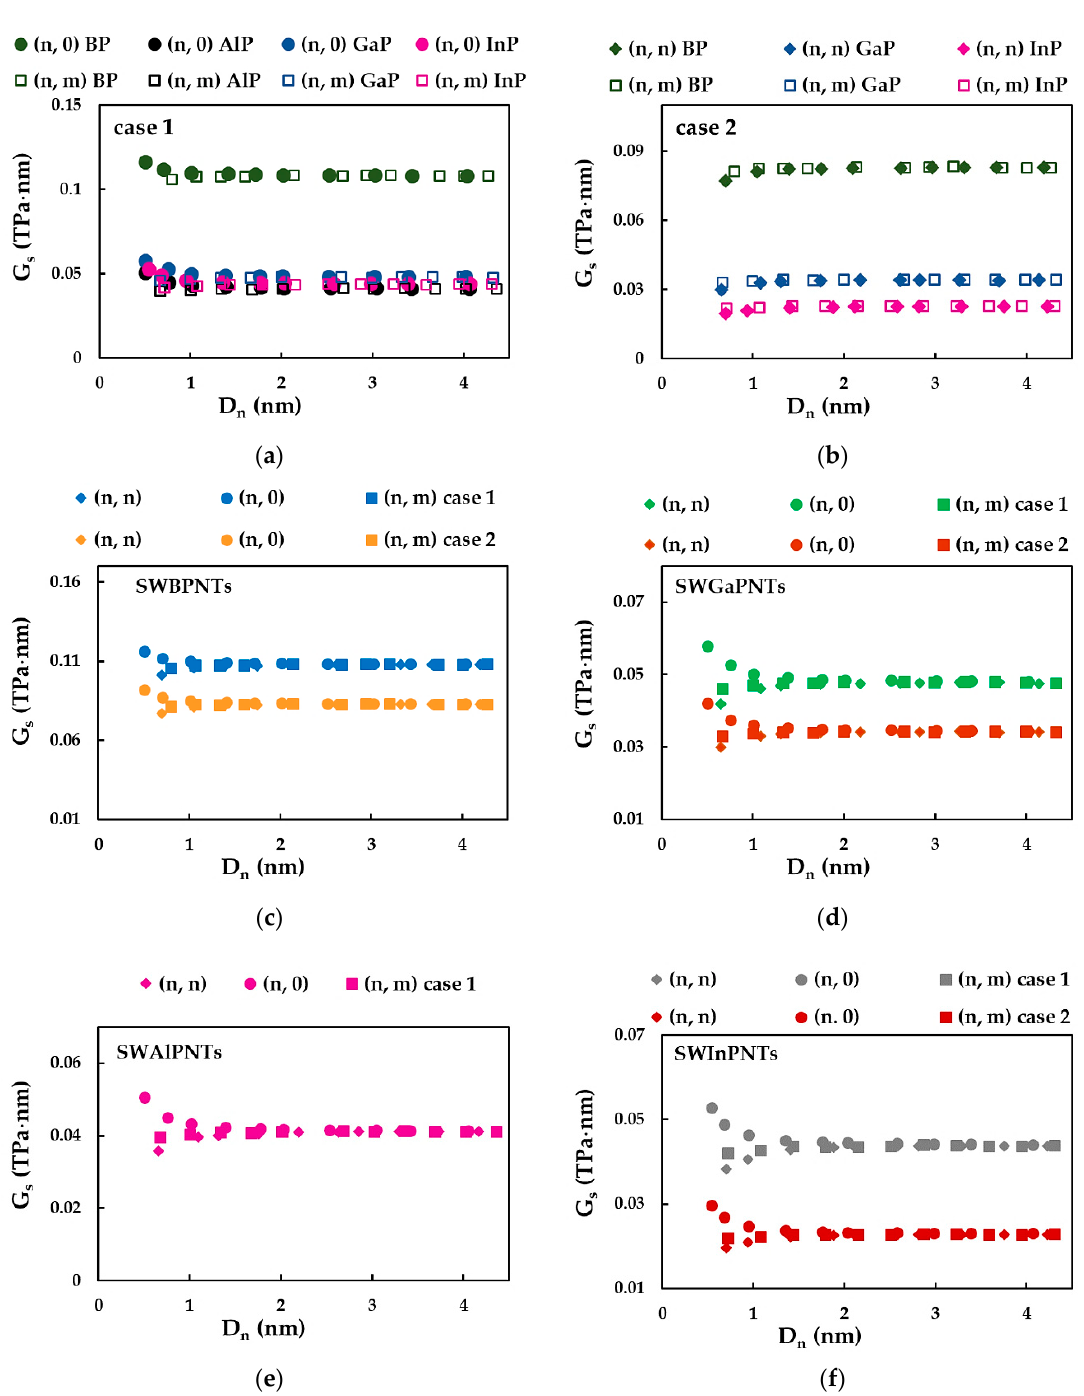
Figure 15. Evolution of the surface shear modulus, G s , as a function of the nanotube diameter, D n : ( a ) for case 1 of (n, 0) and (n, m) SWBPNTs, SWAlPNTs, SWGaPNTs and SWInPNTs; ( b ) for case 2 of (n, n) and (n, m) SWBPNTs, SWGaPNTs and SWInPNTs; ( c ) for SWBPNTs; ( d ) for SWGaNTs; ( e ) for SWAlPNTs; and ( f ) for SWInPNTs.